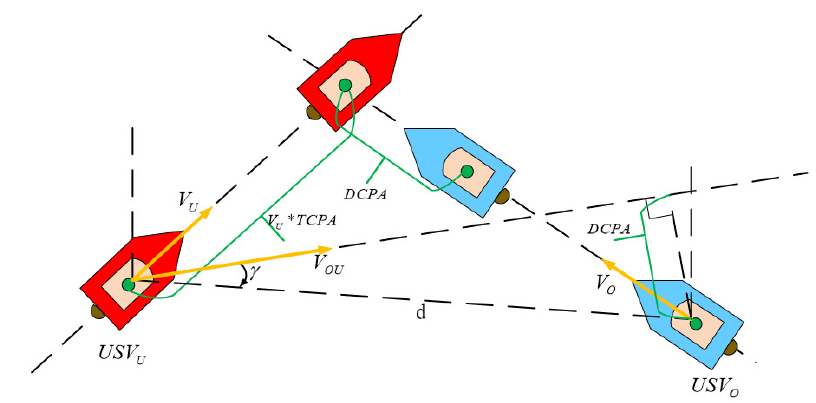
Figure 5. DCPA and